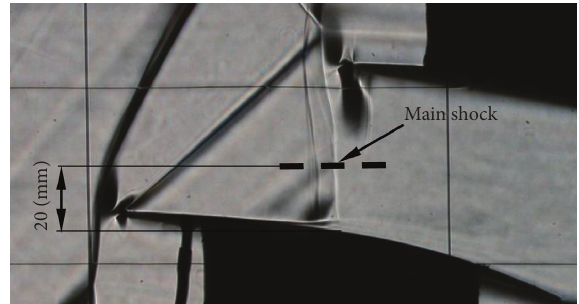
Figure 7: Measurement locations by the fast CCD